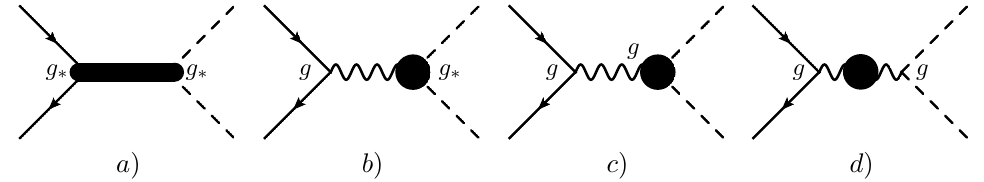
Figure 3 . Contributions to longitudinal diboson processes from di(cid:11)erent BSM scenarios: strongly- coupled quarks and Higgs (a), strongly-coupled Higgs and transverse vectors (b), and \Weak" type models